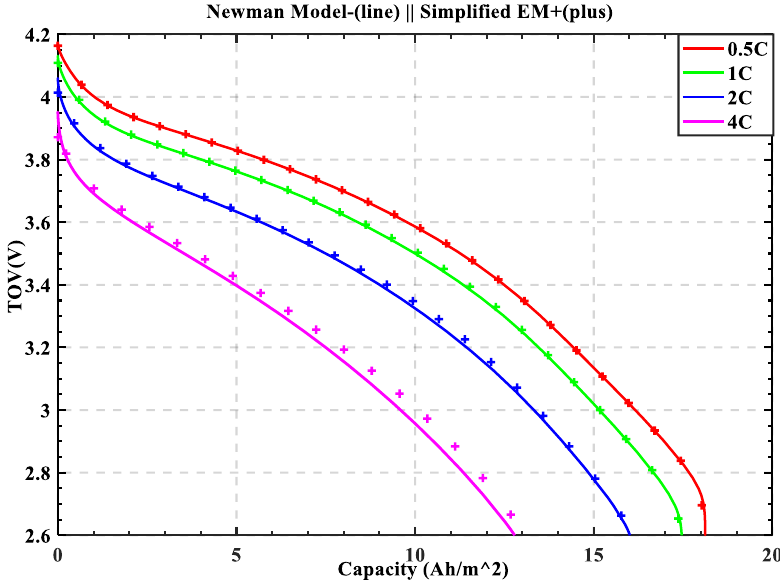
Figure 3. Performance evaluation for battery TOV under different C-rates.